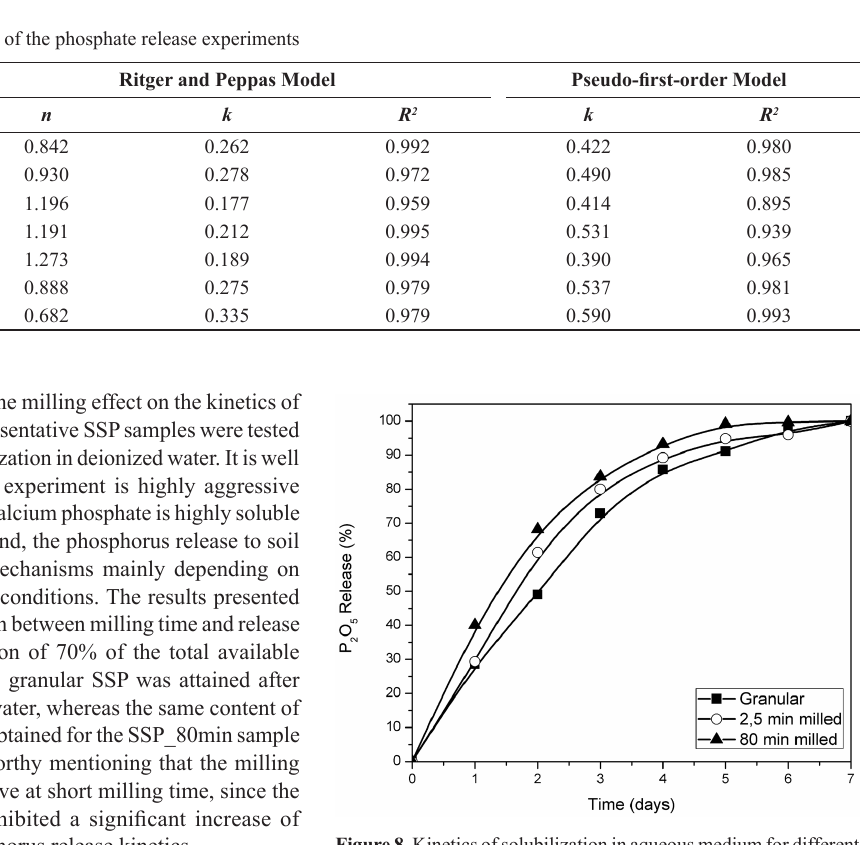
Figure 8. Kinetics of solubilization in aqueous medium for different samples of SSP fertilizers.